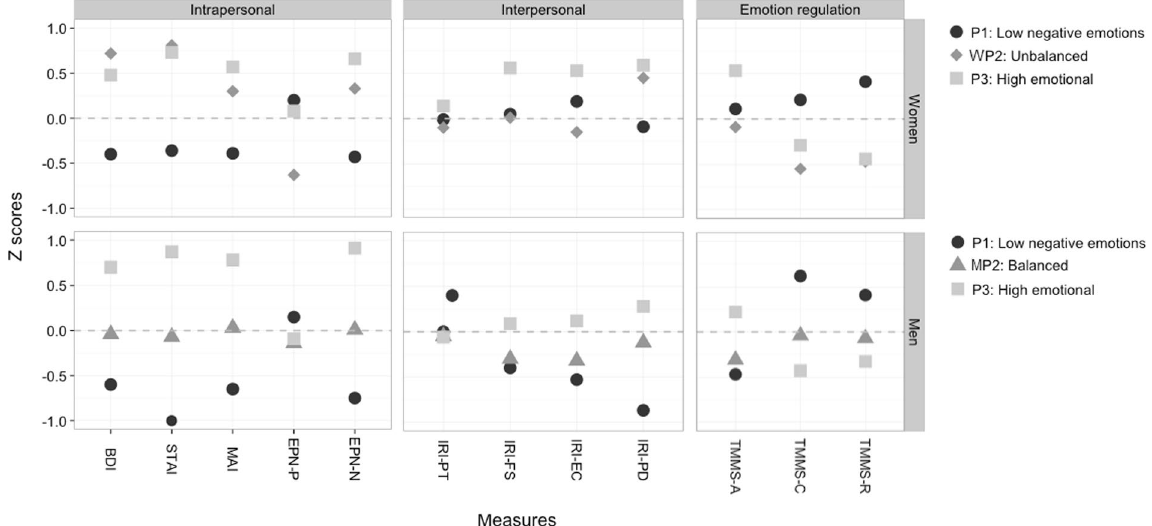
Figure 2. Correlates of the ANPS profiles in Sample 2. The figure represents the standardized scores (Z) of the 18 measures of intrapersonal, interpersonal and emotion regulation constructs, by profile and by gender. Profiles 1 and 3 are named the same in men and women: P1 ‘low negative emotions’, and P3 ‘high emotional’. Profile 2 is named differently in men and women (because of qualitative differences between the genders): Women WP2 ‘low positive emotions’, and Men MP2 ‘balanced’. BDI = Beck Depression Inventory short version; STAI = State-Trait Anxiety Inventory-Y; IRI = Interpersonal Reactivity Index (-PT = Perspective Taking, -FS = Fantasy Scale, -EC = Empathic Concern, -PD = Personal Distress); MAI-Multidimensional Anger Inventory; EPN-P = Positive and Negative Emotionality Questionnaire - Positive subscale; EPN-N = Positive and Negative Emotionality Questionnaire - Negative subscale; TMMS = Trait Meta Mood Scale (-A = Attention towards emotions, -C = Clarity of feelings, -R =